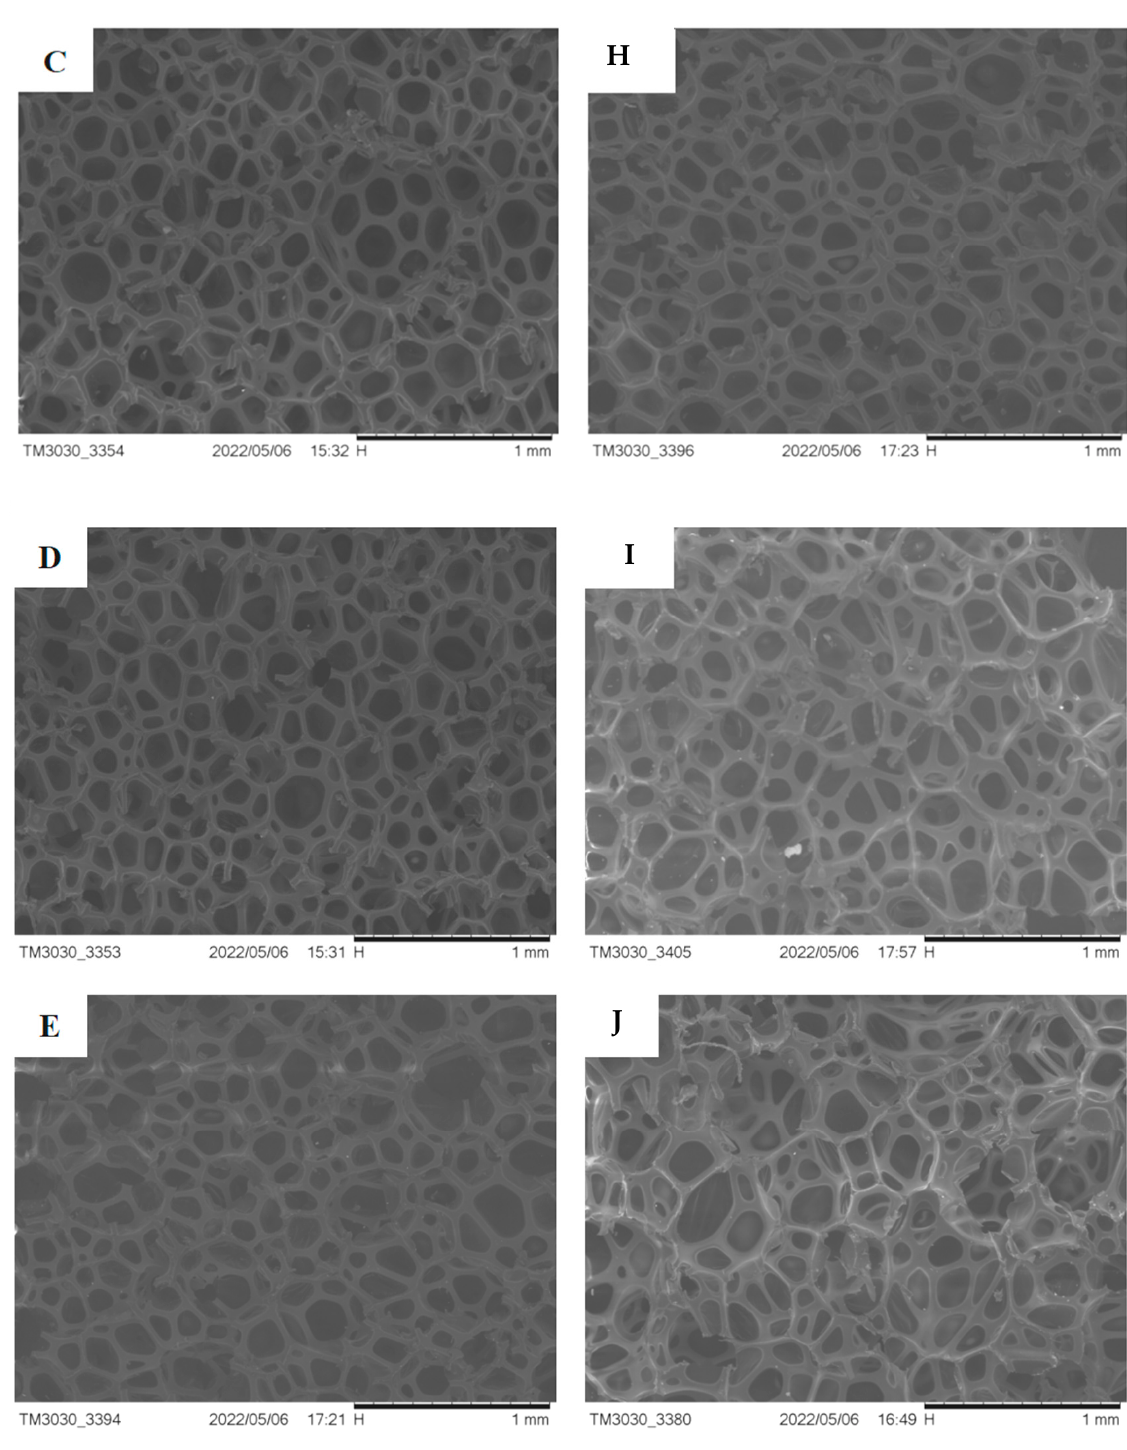
Figure 14. SEM electron microscopic analysis of regenerated polyurethane foam for catalysts of different systems ( A – E , F – J Corresponding to 0.025%, 0.050%, 0.075%, 0.100% and 0.200%, respectively).